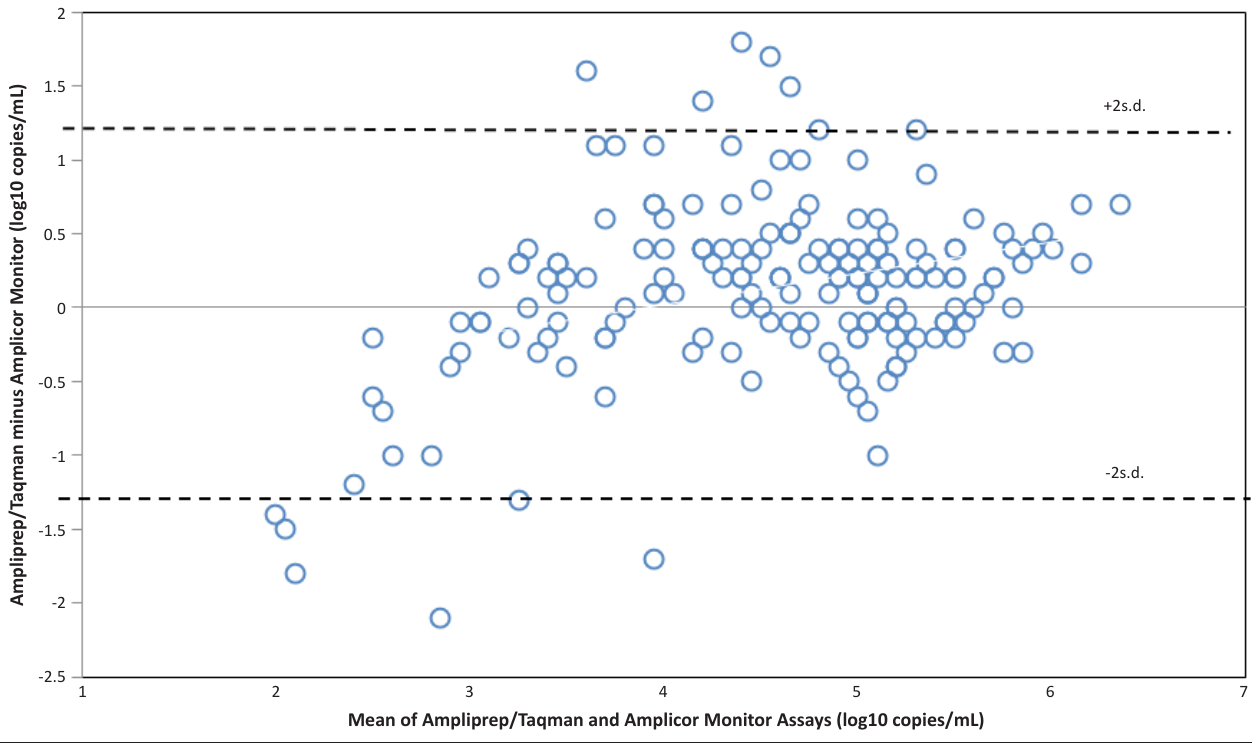
FIGURE 2: A Bland-Altman plot showing the degree of agreement between the COBAS Ampliprep/Taqman and the COBAS Amplicor monitor assays. The numbers of samples ranging within the mean ±2 s.d. interval is 163 of 176 (94.2 %